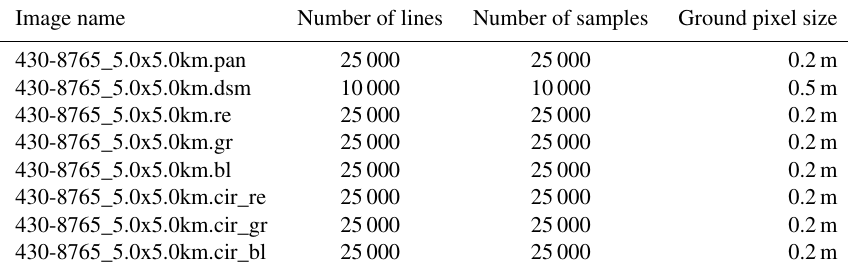
Table B1. Image size and pixel size of individual HRSC-AX im-